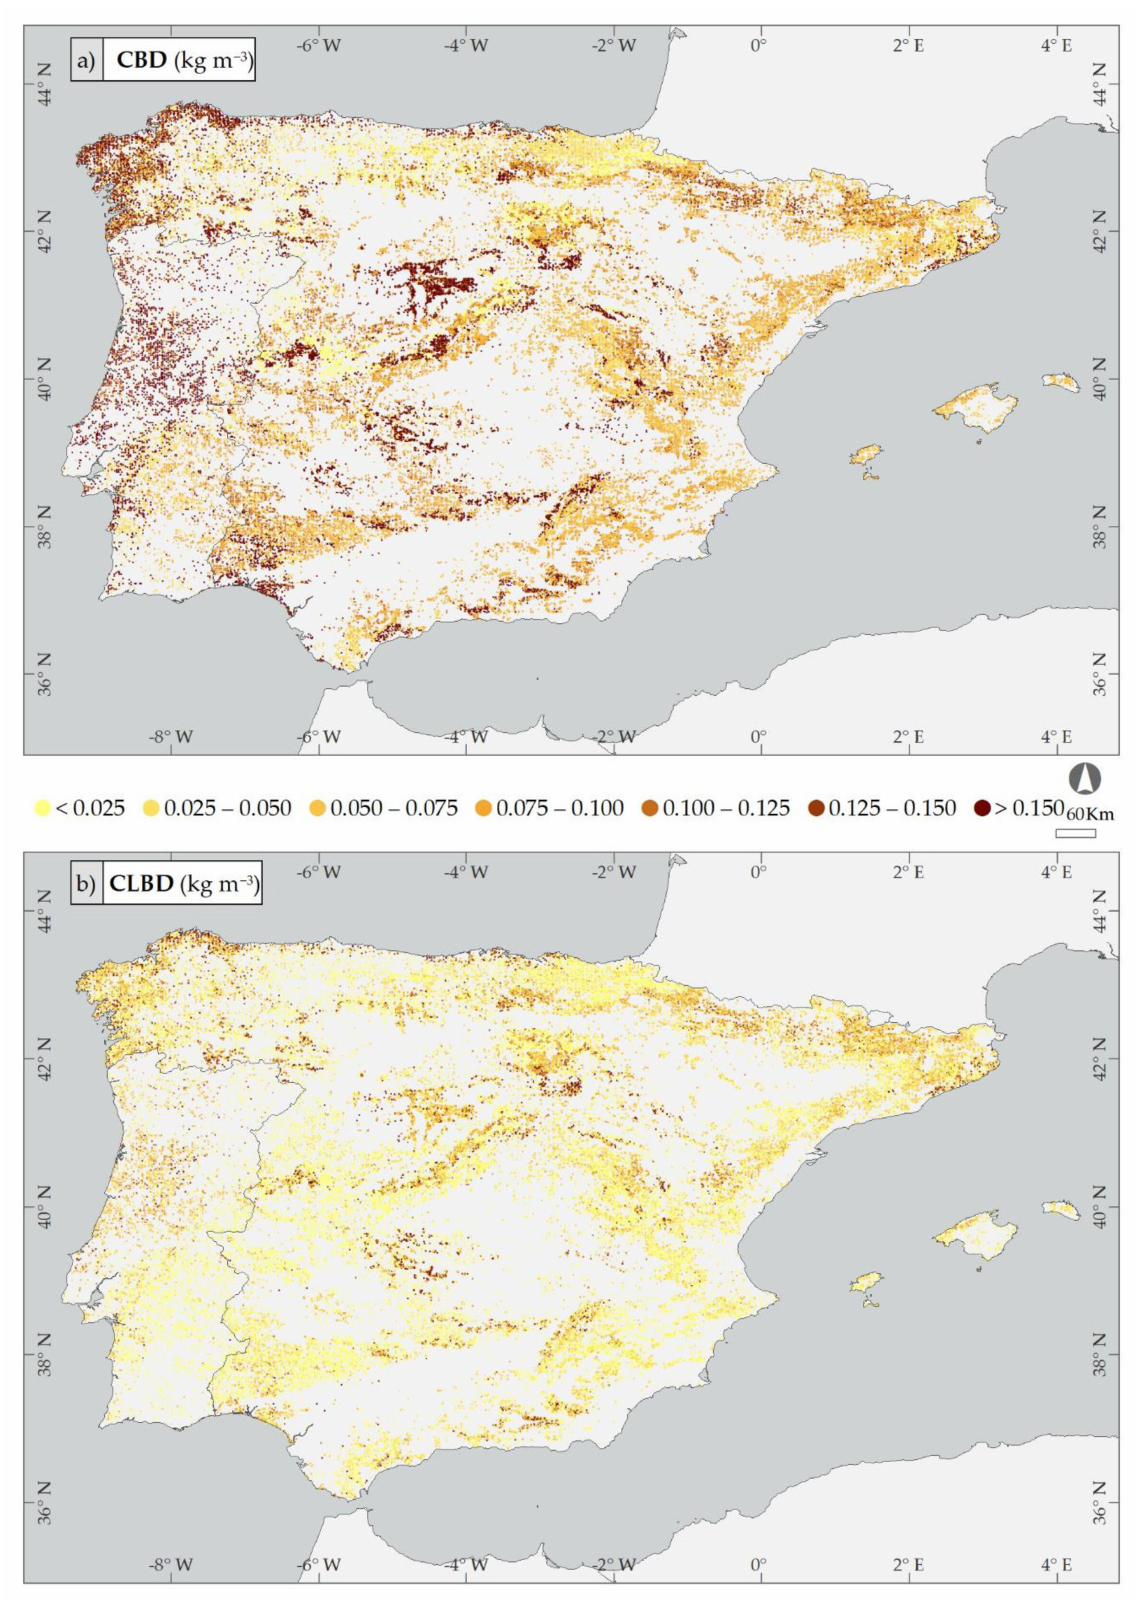
Figure 14. Values of ( a ) tree Crown bulk density (CBD) and ( b ) Canopy Layer Bulk Density (CLBD) per NFIs plots in the Iberian